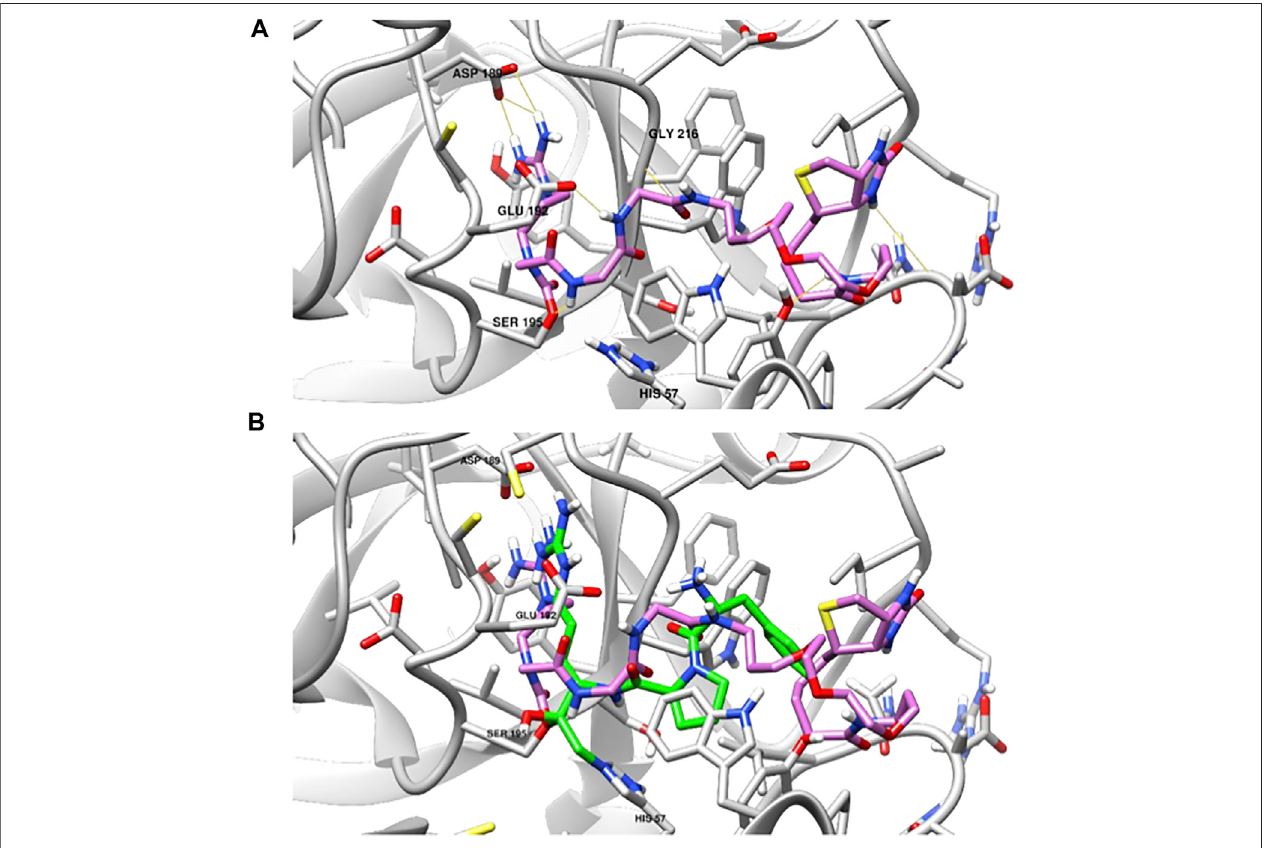
FIGURE 13 | Covalent docking studies of NAP858 with thrombin. (A) Active site of thrombin (PDB: 1DWE) covalently bound to NAP858 via carbamate linker to SER195 (hydrogen bonds indicated in yellow). (B) Superimposed view of NAP858 (pink) and H -D-Phe-Pro-Arg-CMK (green), covalently bound to the active site of